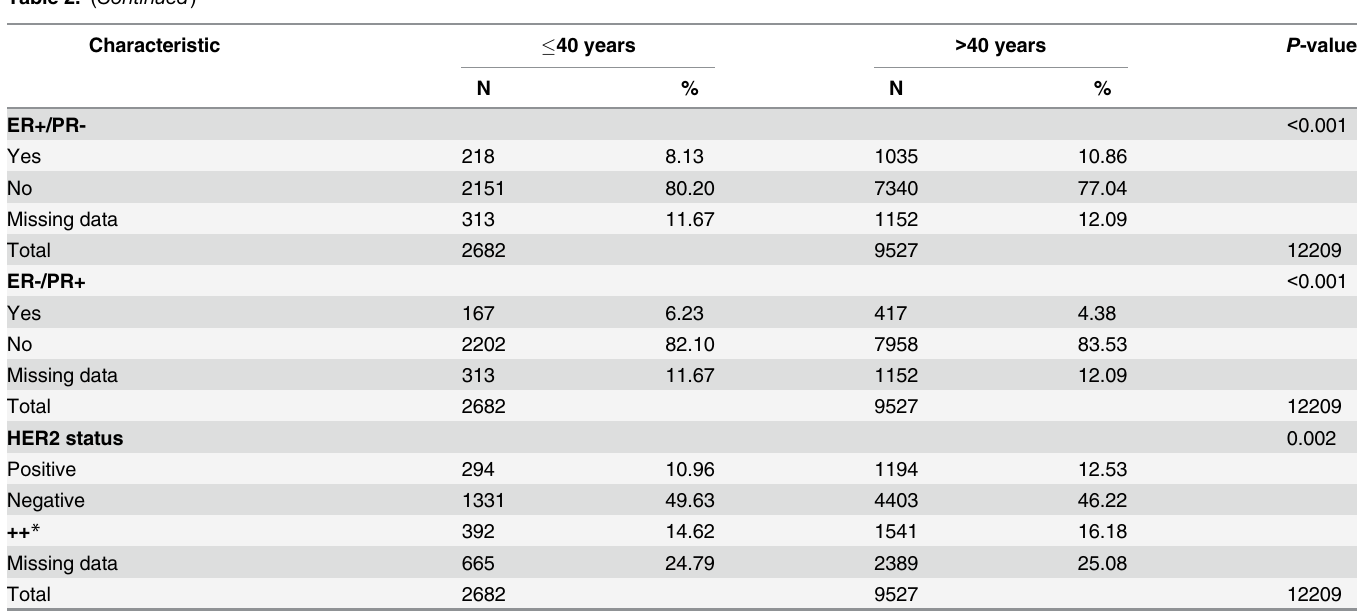
This was significantly lower (p = 0.001) than the number observed in the older ( > 40 years) group, i.e., 30.46% (4.20% + 26.26%) of cases. This suggests that the tumor diameter was greater in young patients at the time of diagnosis. Similarly, the probability of axillary lymph node metastases was higher in the young patients compared to the older patients (51.83%. vs. 47.92%, p = 0.006). The probability of distant metastases was also higher in the young patient group compared to the older group (1.23%. vs. 0.70%, p = 0.008). But the difference in distribution of TNM stage between two age groups didn ’ t reach statistical significance (p = 0.226). Similarly, we observed a tendency in the tumor grading in young patients (i.e., the grade was higher) compared to older patients, but this was not statistically significant (p = 0.052). Additionally, we found no significant differences between the two age groups in the other clinicopathological features, such as tumor site, pathologi- cal diagnosis, and so on (data not listed). As to biomarker expression levels, there were significant differences in progesterone recep- tor (PR) and HER2 expression levels in breast cancer tissues of different age groups (Table 2). The PR positive expression rate was higher in young ( (cid:1) 40 years) patients compared with older ( > 40 year) patients (53.88%. vs. 49.09%, p < 0.001; Table 2). In addition, the HER2 negative expression rate was higher in the young age group compared with the older age group (49.63%. vs. 46.22%, p = 0.002; Table 2). As double positive expression of the estrogen receptor (ER) and PR (i.e., ER+/PR+) can indicate a better endocrine therapy response, we performed a combined analysis of ER and PR expression. The ER+/PR+ double positive expression rate was higher in young patients than older patients (47.39% vs. 44.53%, p = 0.010; Table 2). Young patients also had a higher PR (ER-/PR+) single positive expression rate (6.23%. vs. 4.38%, p < 0.001), and lower ER (ER +/PR-) single positive expression rate compared with older patients (8.13%. vs. 10.86%, p < 0.001; Table 2). However, no significant differences in total ER expression levels were found between the two